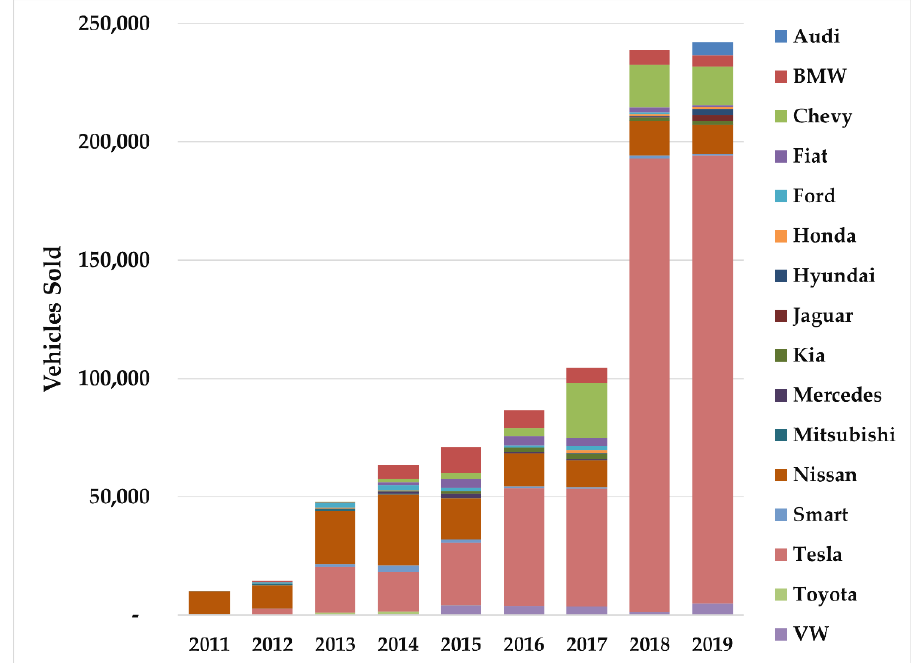
Figure 5. Electric vehicles sold by manufacturer and year. Number of EVs sold is broken down by manufacturer name. This chart does not include plug-in hybrid electric vehicles (data source: [17]).